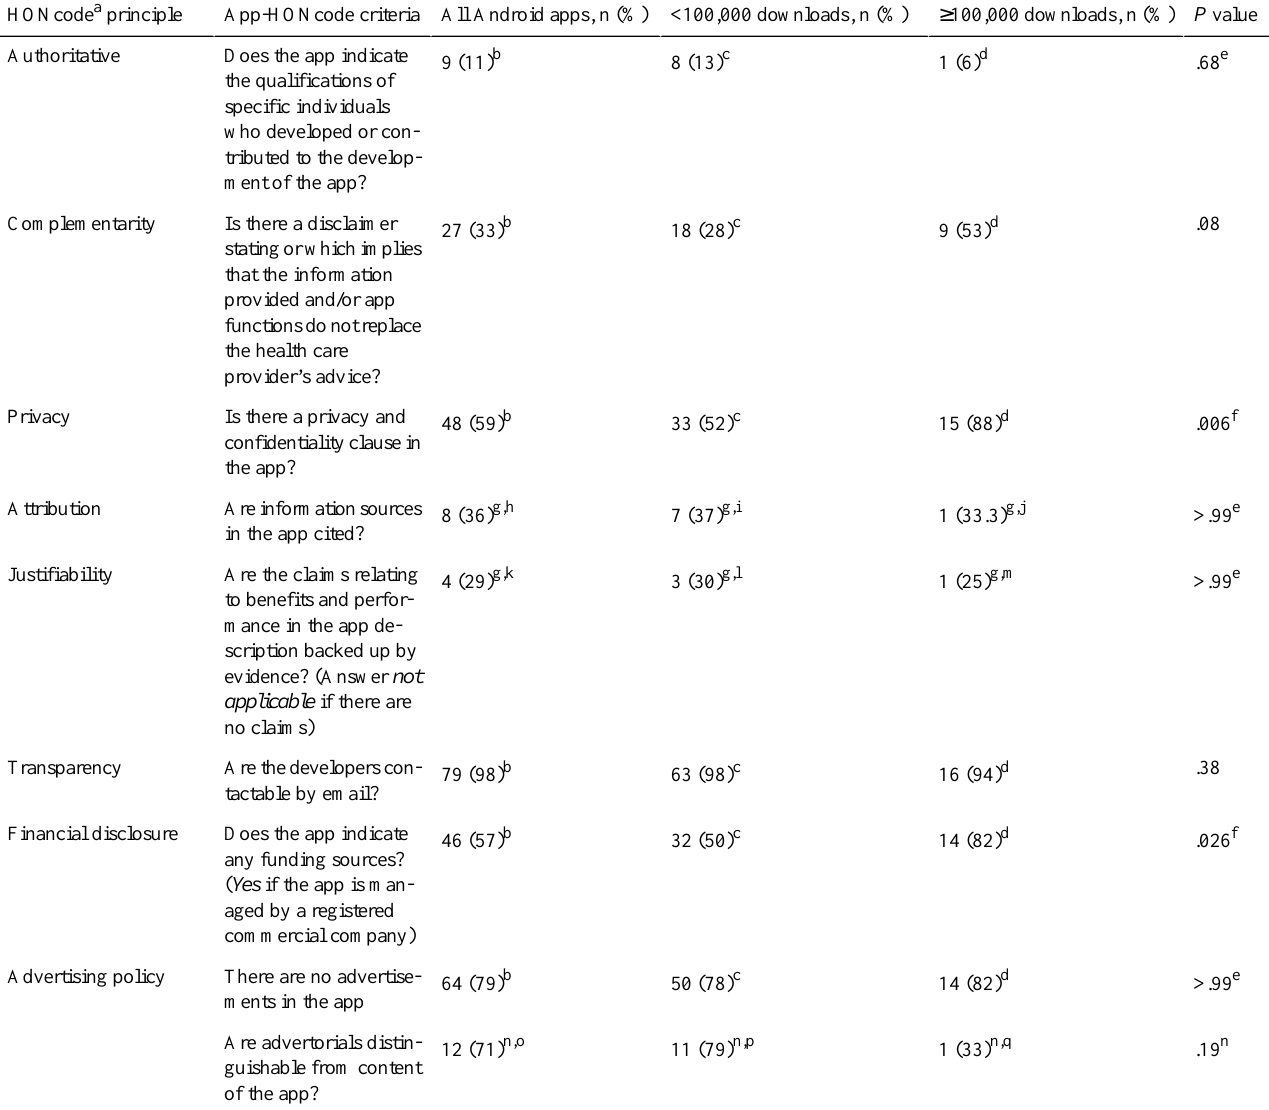
Table 3. Profile of Android app attributes grouped by the number of